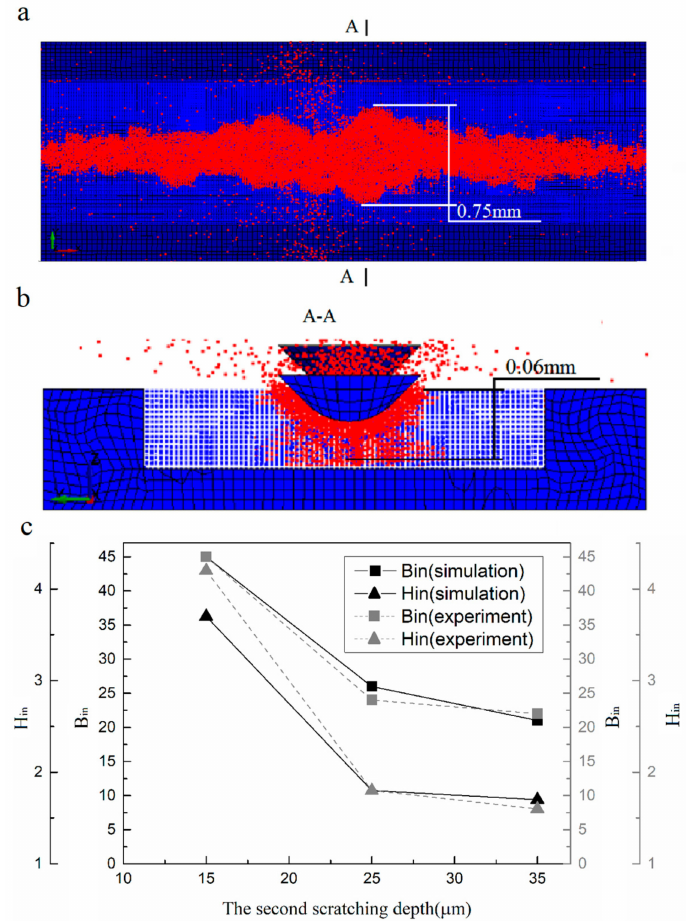
Figure 4. Morphology of the groove after two grit scratching of single crystal SiC with di ff erent Z-axis spacings under the brittle removal mode, ( a ) morphology of the groove with the ∆ d z of 25 µ m, ( b ) material damage in Section A, and ( c ) bin and hin of twice scratching with di ff erent spacings in Z-axis direction for simulation and